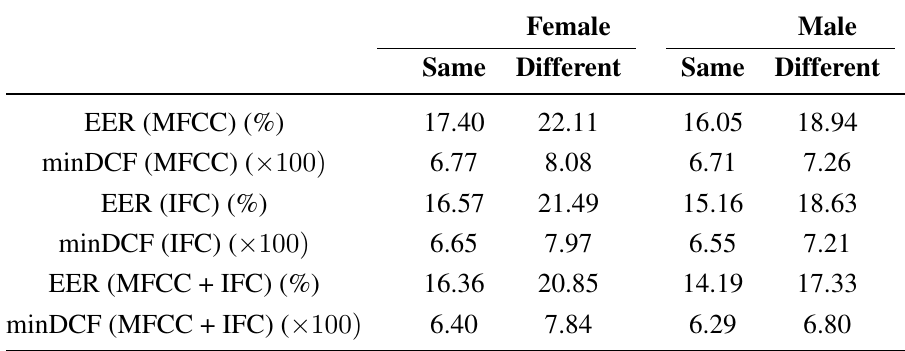
Table 3. Mean EER and mean minDCF of individual EERs and the minDCFs of the